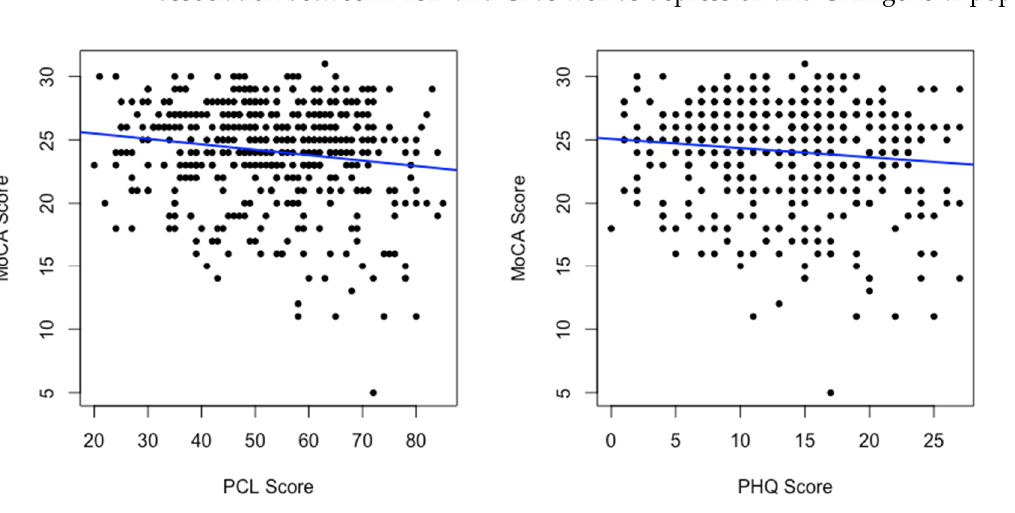
Figure 2. Linear regression of MoCA scores on PCL scores and PHQ scores.